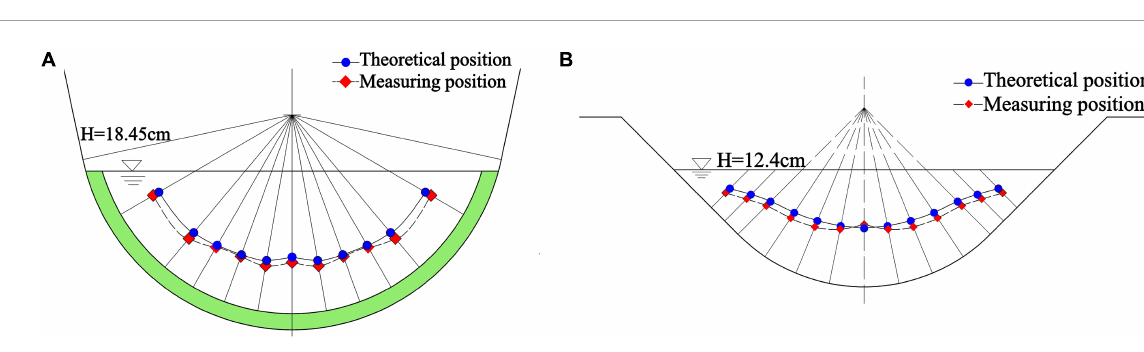
FIGURE5 Comparison between theoretical position and measured position of representative point of normal average velocity. (A) vegetated U-shaped channel, (B) smooth arc-bottom trapezium